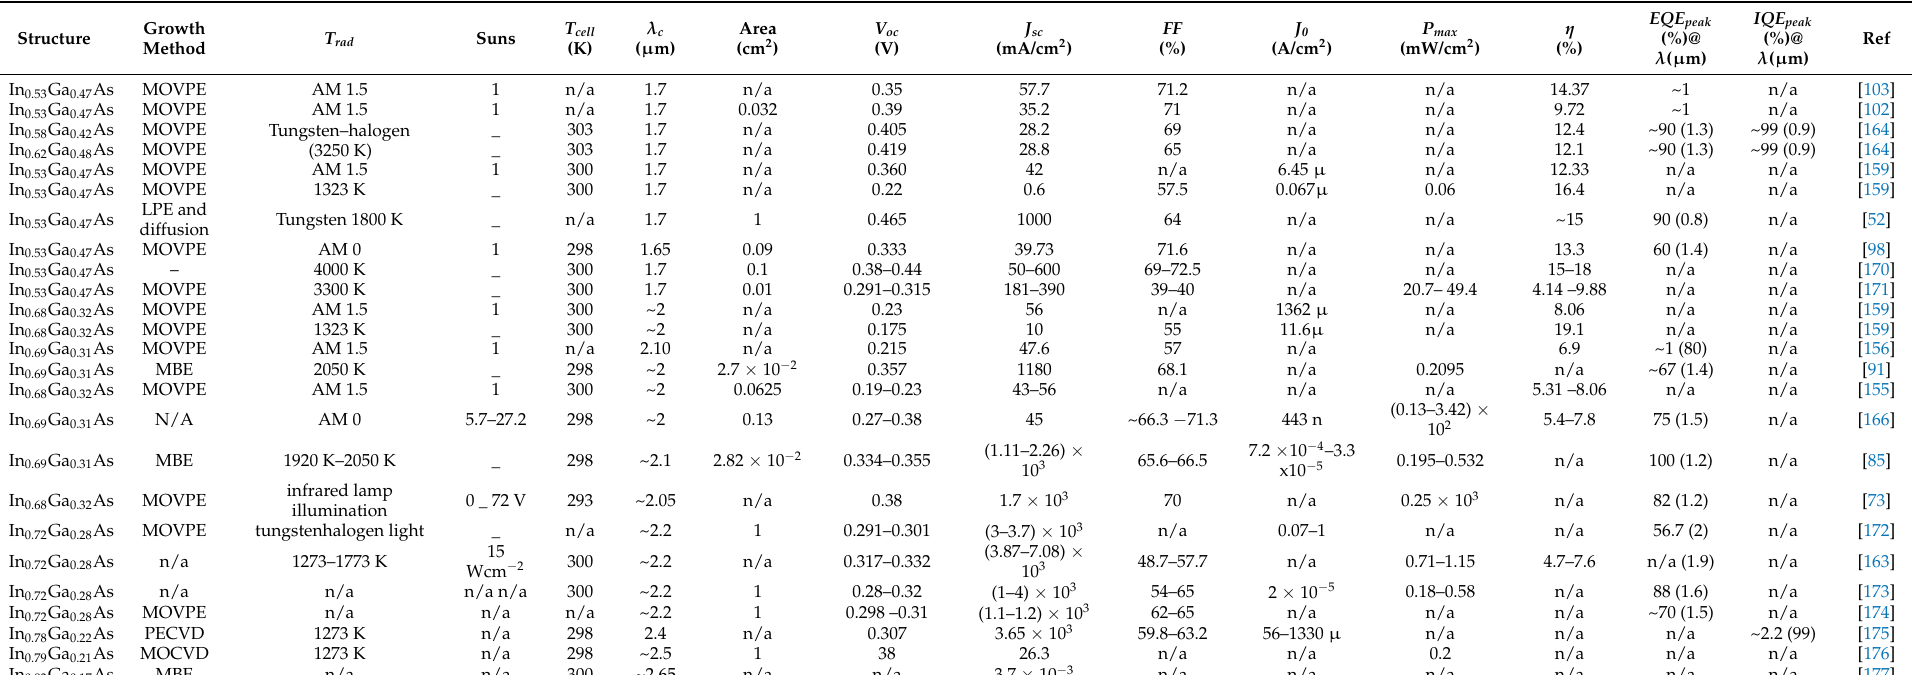
Table 4. Performance comparison of In x Ga 1-x As-based TPV